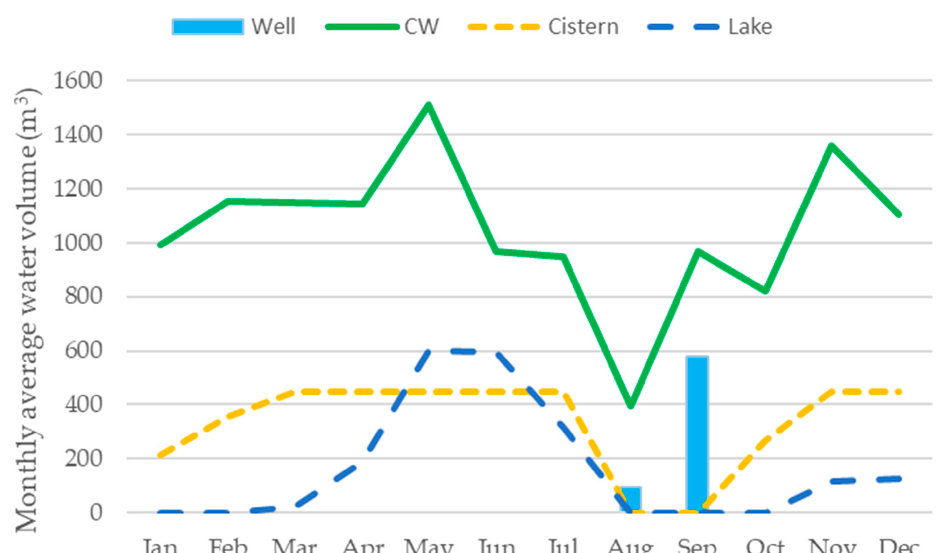
Figure 6. Simulation of the water balance in the campus framework for wastewater recovery for irrigation, considering the combined storage capacity of the water cistern (450 m 3 ) and the campus lake (600 m 3 ). The well water is necessary to overcome the storage shortage in August and September. Maximum flowrate in the CW input stream is expected during May. Considering a maximum design flow rate of 0.052 m 3 /m 2 /day for stratified solid waste-filled CWs [45], it is required to set up a total area of wetland beds of 900 m 2 . This area can be achieved using nine CW beds, each 5 m wide and 20 m